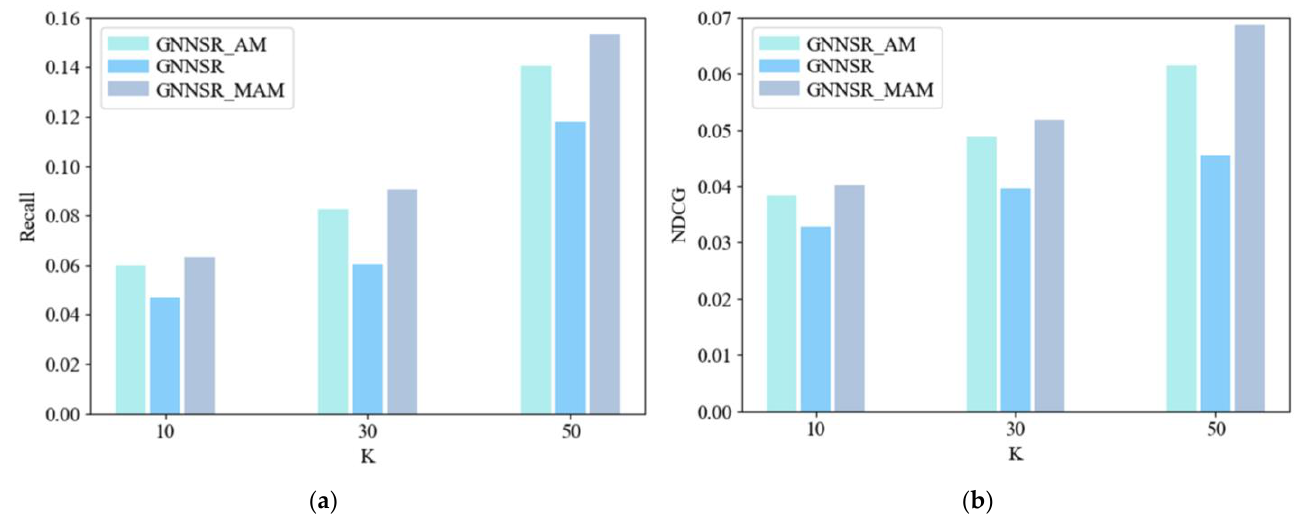
Figure 8. Impact of different attention mechanisms on the algorithm. ( a ) Recall@K; ( b ) NDCG@K. Compared with GNNSR, the Recall of GNNSR_MAM increases by 43.9%, and the